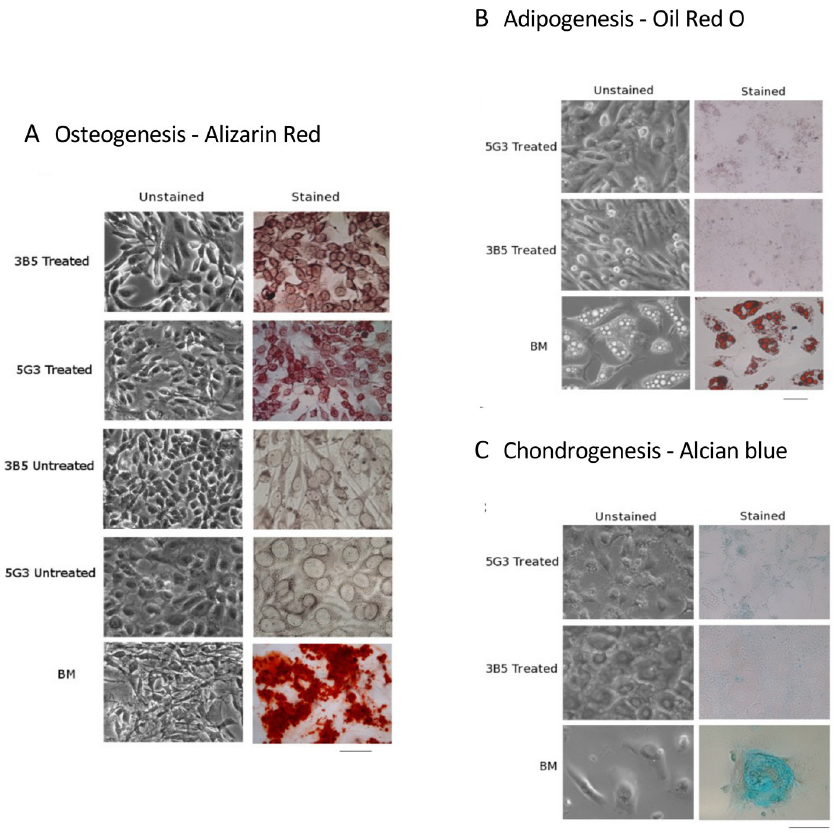
Fig 3. Splenic stromal lines reflect osteoprogenitors. The 5G3 and 3B5 stromal cell lines were cultured under different conditions to induce osteogenic, adipogenic and chondrogenic differentiation, with medium replacement every 3 days. Controls were cultured under normal conditions. In parallel, bone marrow derived MSCs were induced to differentiate under the same growth regime. (A) Cells were cultured for 21 days under mineralization conditions to induce osteogenesis, and then stained after 21 days with Alizarin Red S stain. (B) Cells were cultured for 21 days under chondrogenic conditions and then stained with Alcian Blue. (C) Cells were cultured for 14 days under adipogenic conditions and then stained with Oil Red O. Cells were photographed under bright field microscopy. Unstained cells were photographed under phase. Bar represents 100 μ m. Data reflect a representative result from replicated